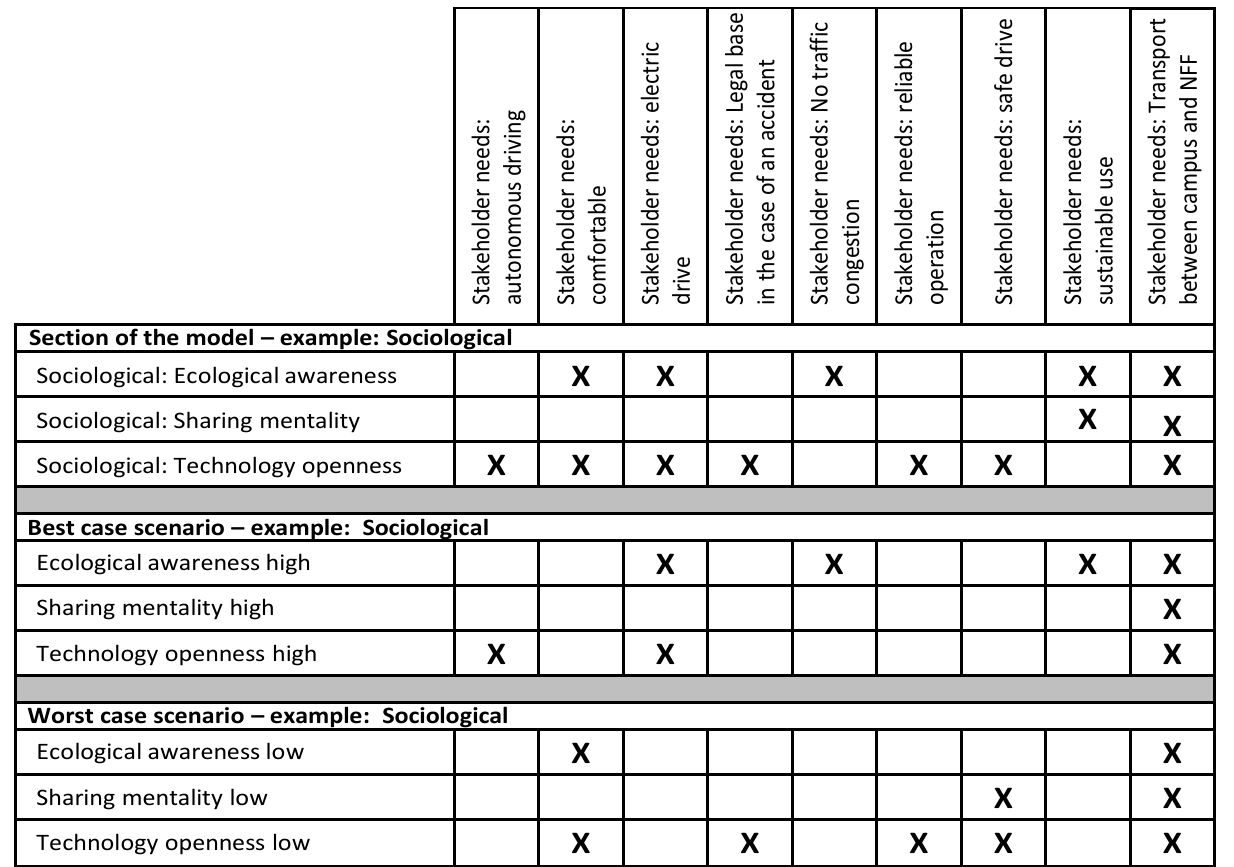
Figure 6. Relationships between scenario and stakeholder needs.